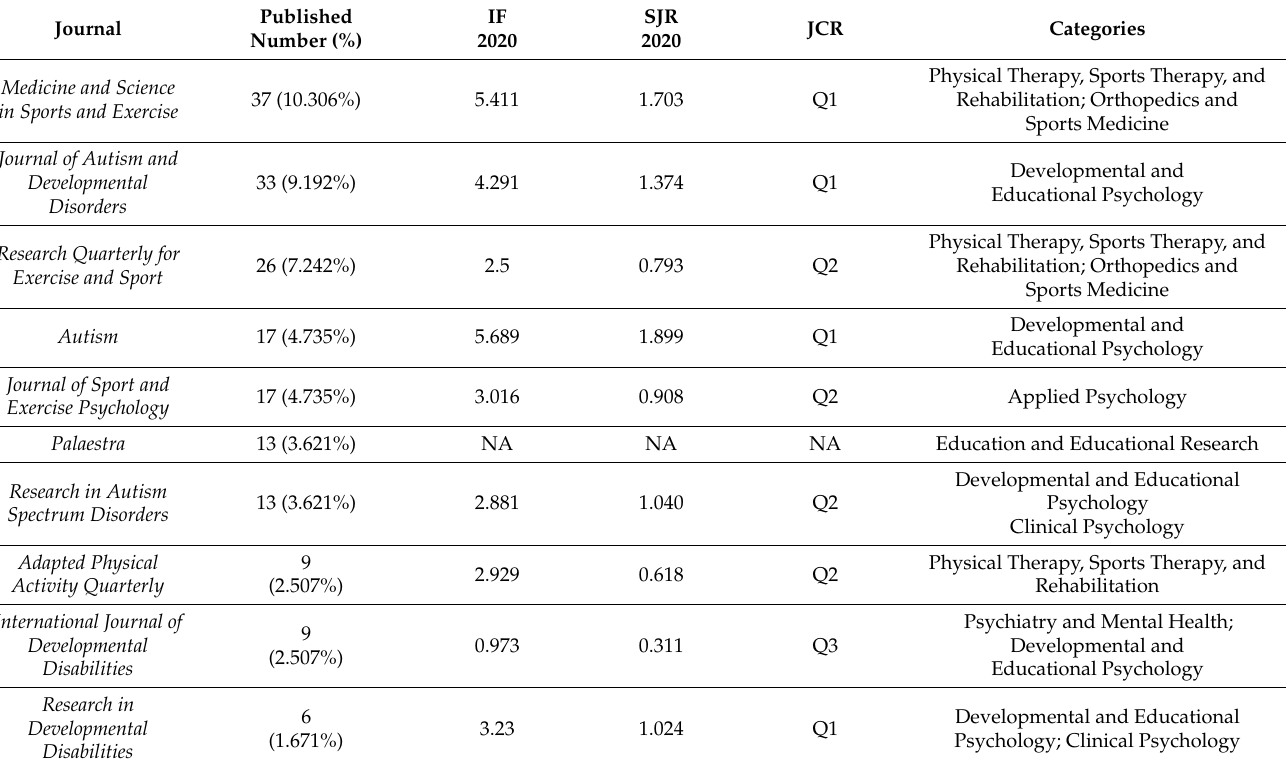
Table 2. The top 10 productive journals on PA research of ASD.